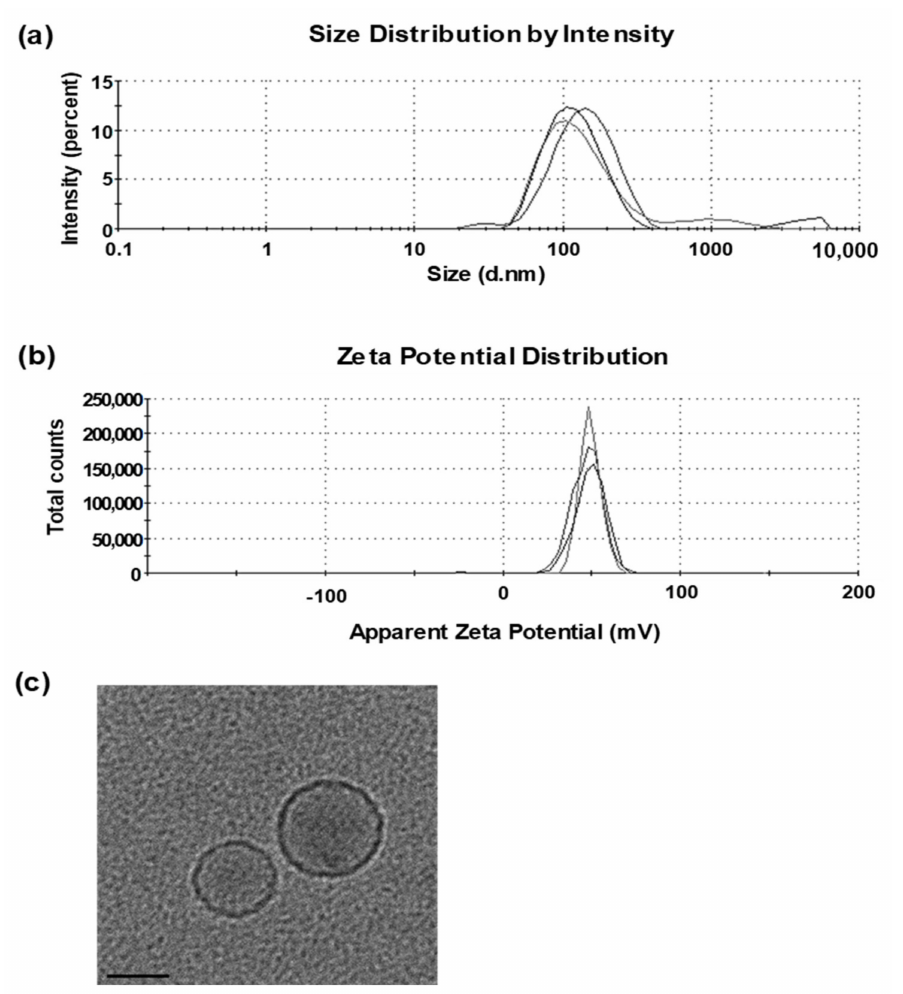
Figure 1. Particle size and morphology of the cationic liposomes. Representative histograms show- ing the results of three measurements of the particle size ( a ) and zeta potential ( b ) of liposomes. ( c ) Images of liposomes observed under a cryogenic transmission electron microscope (cryo-TEM). Scale bar = 50 nm.